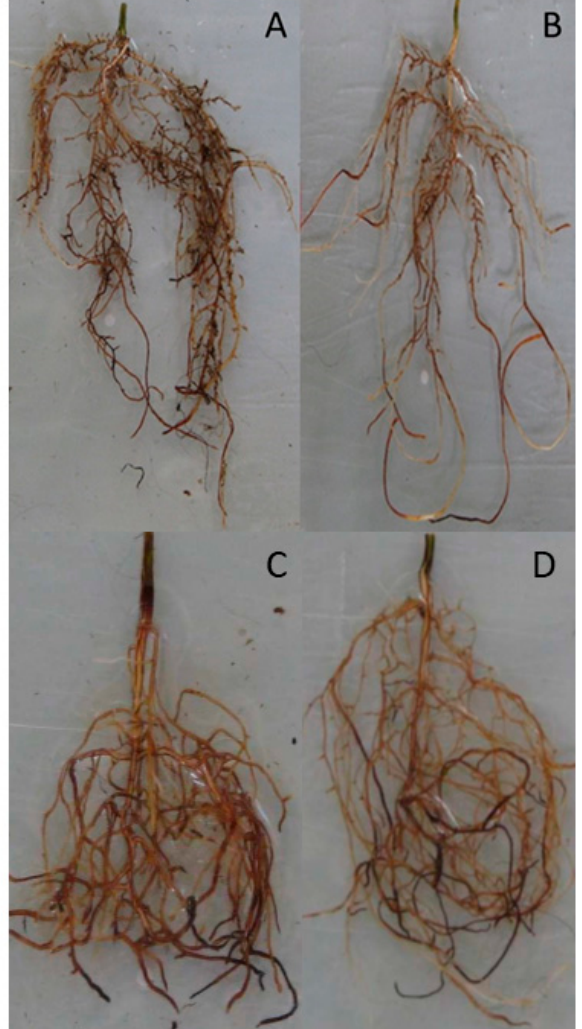
Figure 2. E ff ect of the blue light (BL) proportion on the root morphology in Norway spruce ( A , B ) and subalpine fir ( C , D ) after 9 weeks of growth under a continuous lighting of 300 µ mol m − 2 s − 1 using HPS + blue LED (30% BL) ( A , C ) or HPS lamps (5% BL) ( B , D ) only, with both resulting in a similar R / FR ratio and phytochrome photostationary state (PPS).